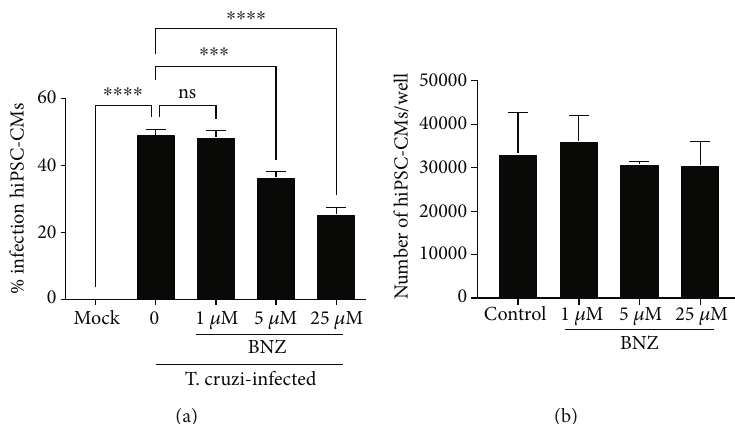
Figure 3: E ff ects of benznidazole (BNZ) on T. cruzi -infected hiPSC-CMs. (a) Percentage of infection BNZ-treated hiPSC-CMs. (b) Number of cardiomyocytes/well in cultures treated with BNZ and control. ∗∗∗ p < 0 : 001 ; ∗∗∗∗ p < 0 : 0001 ; ns = not significant ( p ≥ 0 : 05 ). Table 1: Cytotoxicity against hiPSC-CMs and anti- T. cruzi activity against intracellular amastigotes.